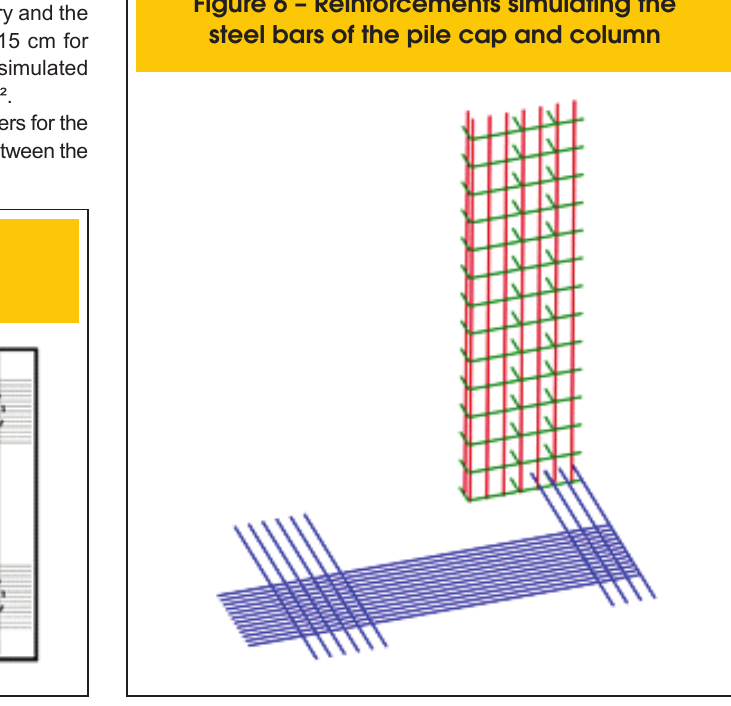
Figure 6 – Reinforcements simulating